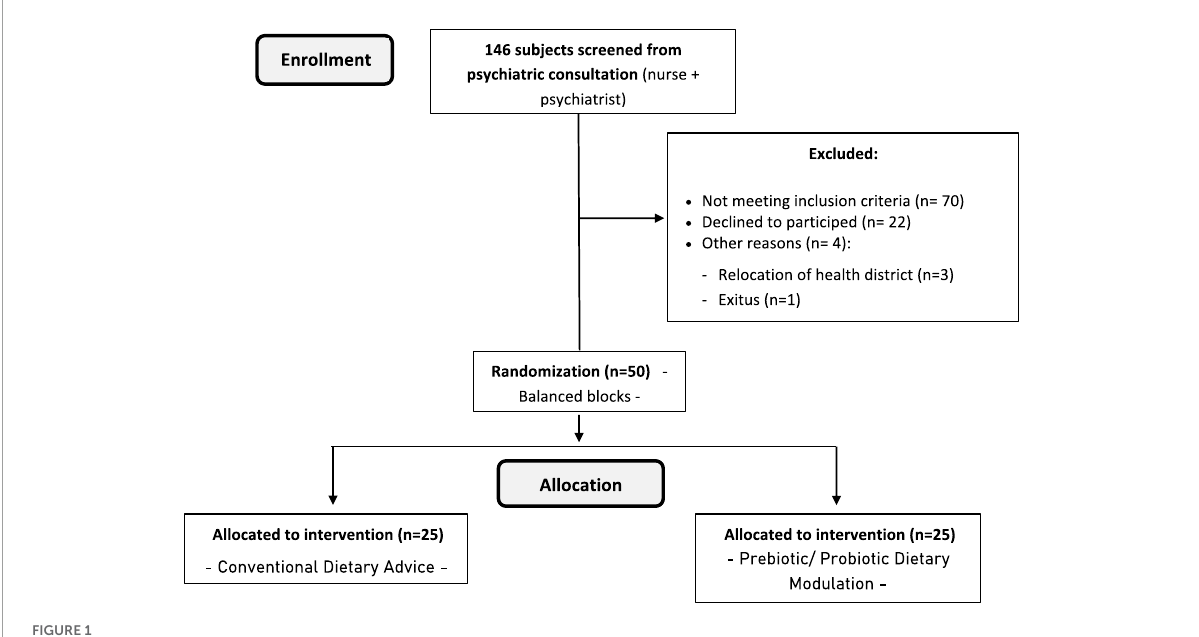
FIGURE1 Flow chart of the participants (CONSORT